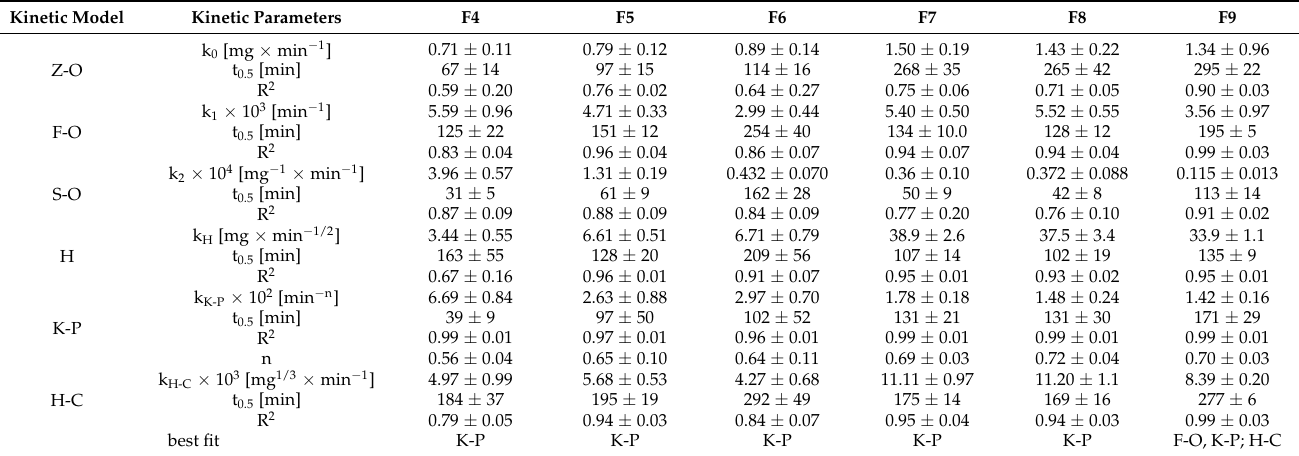
Table 4. The calculated kinetic parameters derived from the release of L and N from formulations